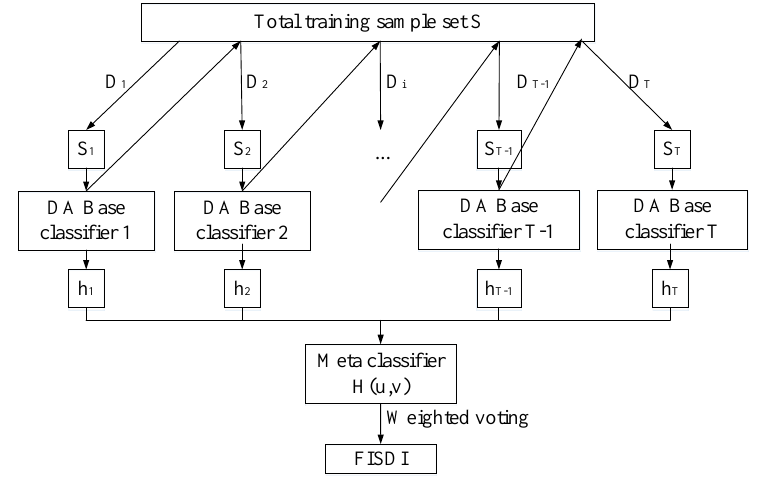
Figure 3. An example of AdaBoost meta-learning strategy.